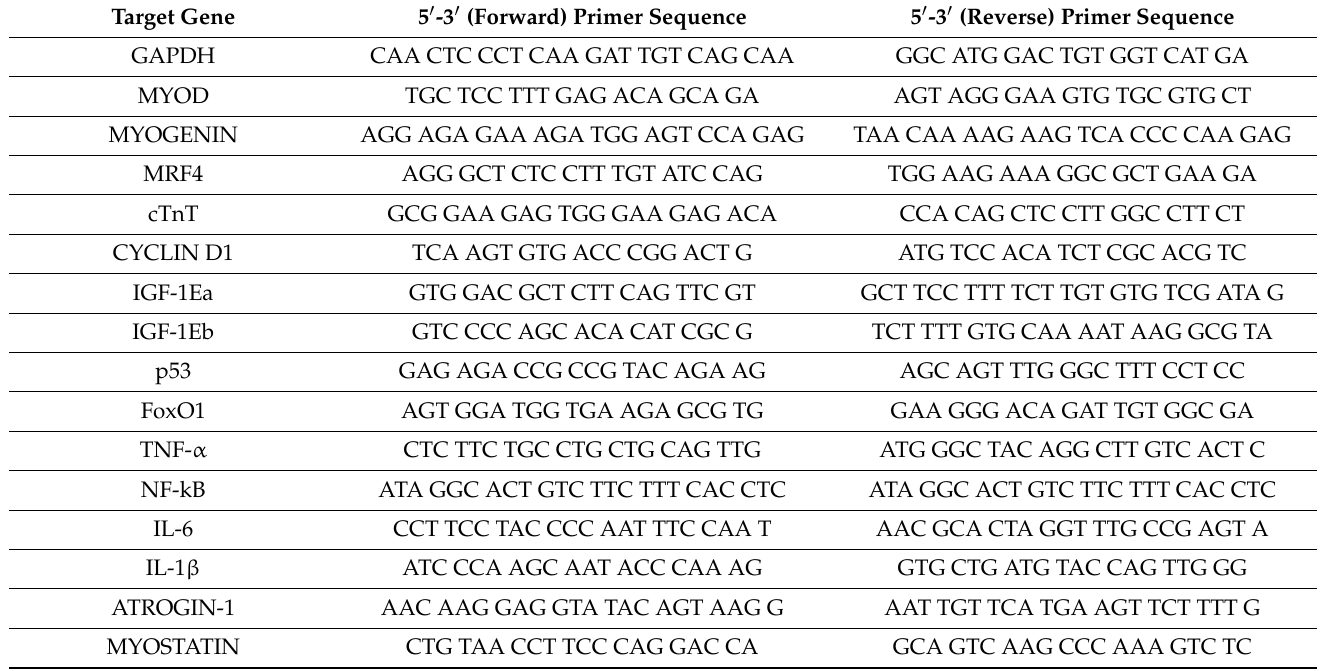
Table 1. The sequences of the specific sets of primers used for RT-PCR